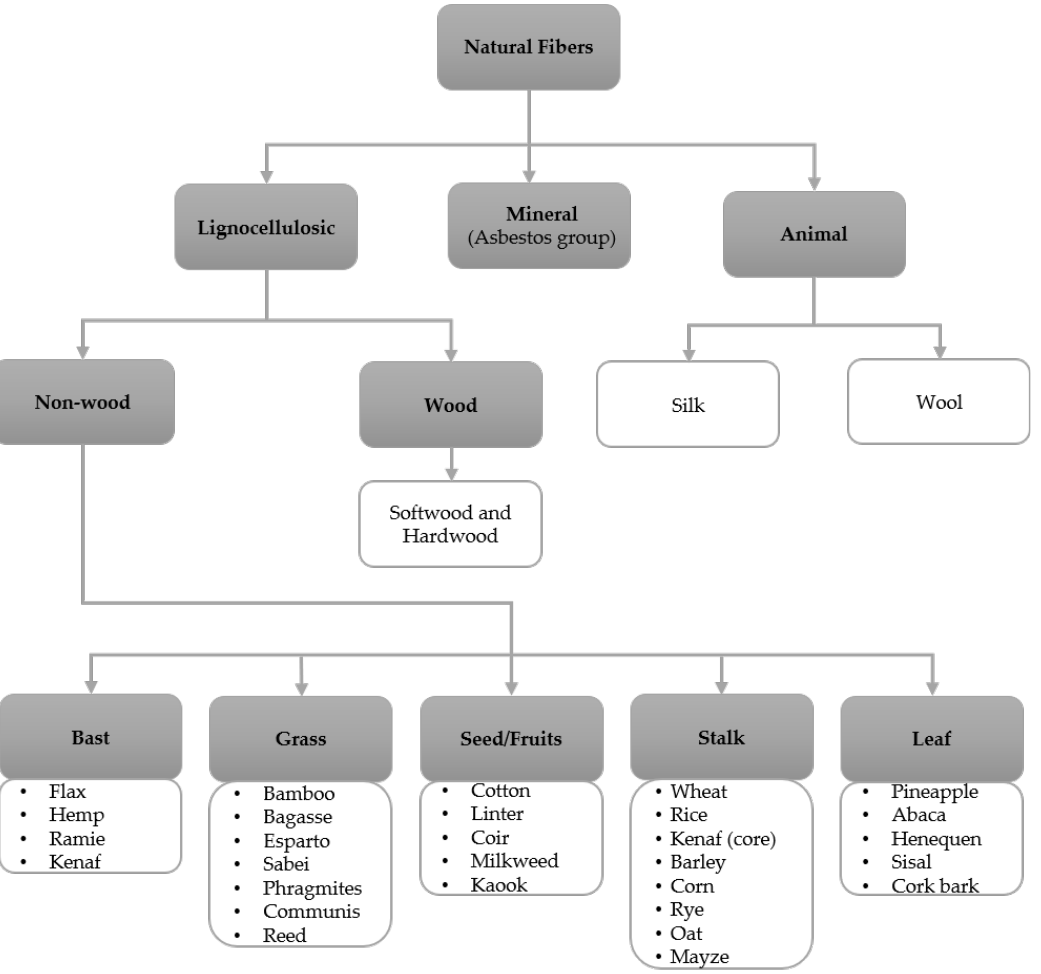
Figure 5. Hao [79], and Gurunathan [81], with permission. Copyright 2018 and 2017, Elsevier. Table 2. Lignocellulosic fibers composition. Fiber